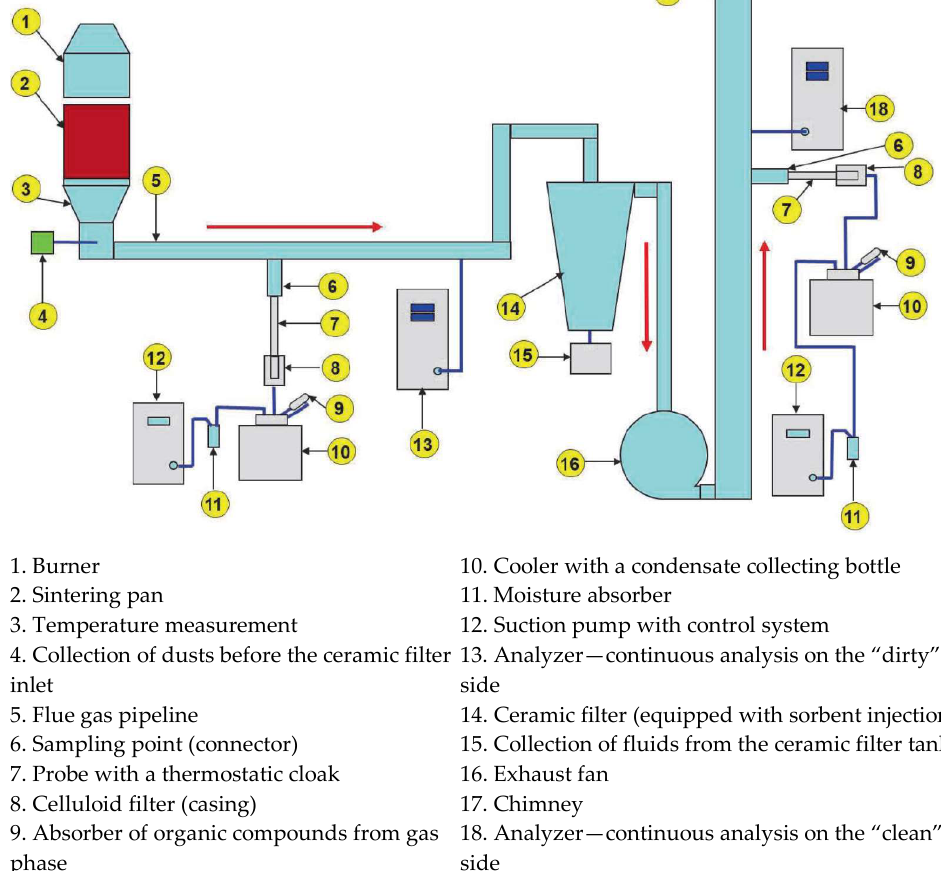
Figure 2. The scheme of the semi-industrial-scale installation for sintering of iron ores and wastes. The semi-industrial sintering installation comprises a sintering site equipped with sintering pans of working height 550 and 300 mm and an ignition furnace of power 250 kW. The gas cleaning process is carried out using a catalytic ceramic filter of high thermal resistance, which allows for cleaning of gases of temperature up to 400°C. The filter (Figure 2 (14)) is additionally equipped with a sorbent dosing system for the improved neutralization of harmful gas components (Figure 3). In the current research, hydrated lime sorbent (HLS) (CAS 1305-62-0) was used.